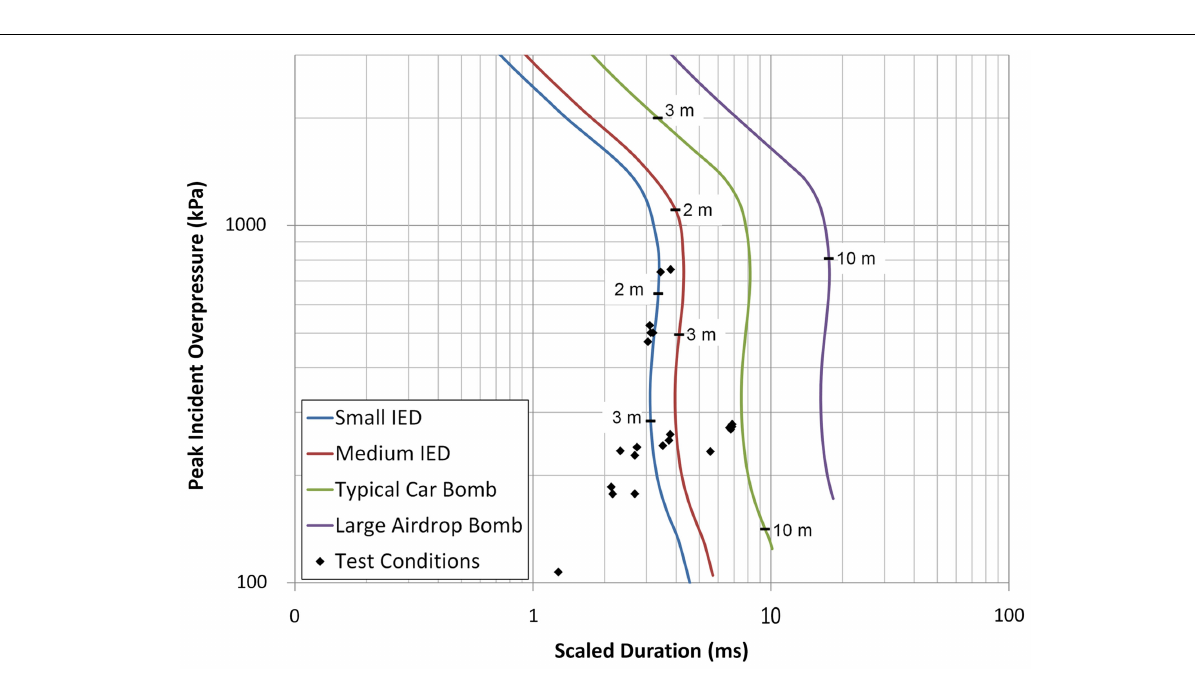
reported comparable peak pressures between the free stream and in the brain. However, the conclusion that ICP is larger than the blastpressureismisleadingbecauseeachof thesestudiescompared the ICP with the incident “side-on” pressure of the blast wave. As